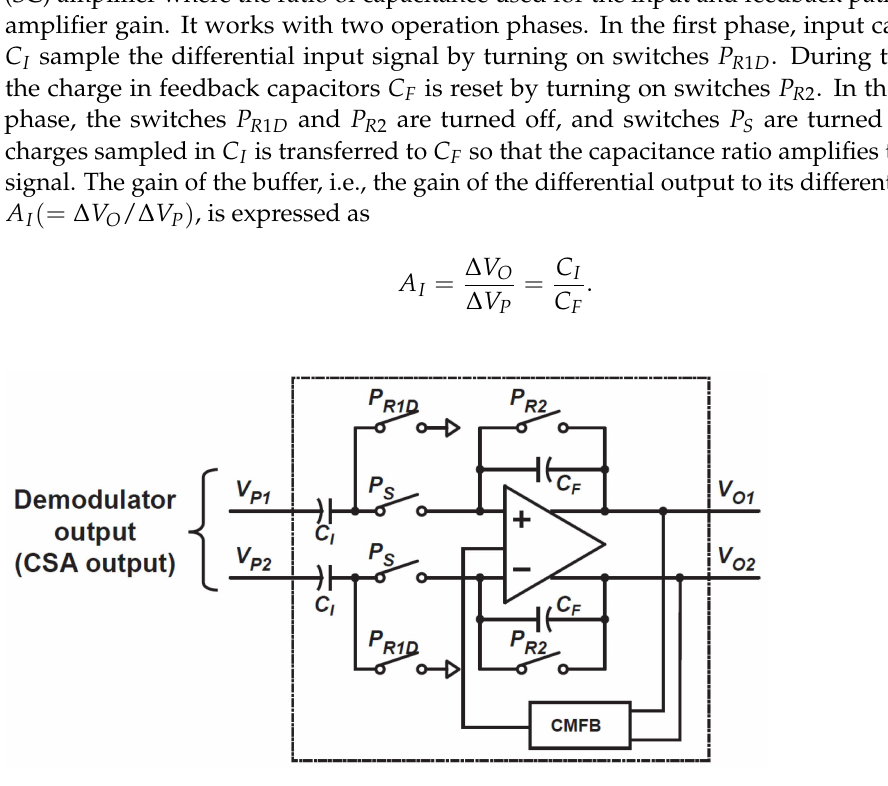
Figure 9. A circuit schematic of the analog processing unit (APU) for a fixed-gain amplifier and integrator. In the fine ToF measurement, the APU performs as a fully differential SC